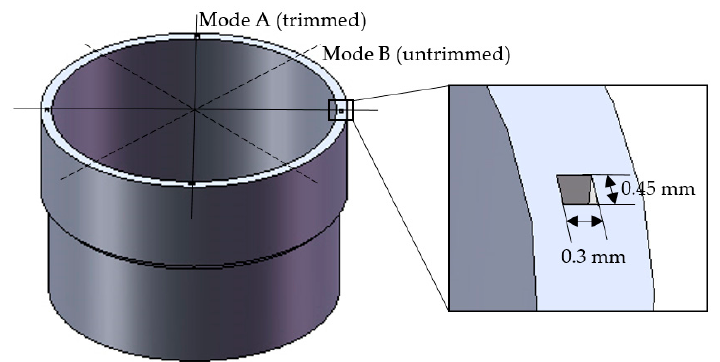
Figure 4. Drilling holes on the top of the resonator.